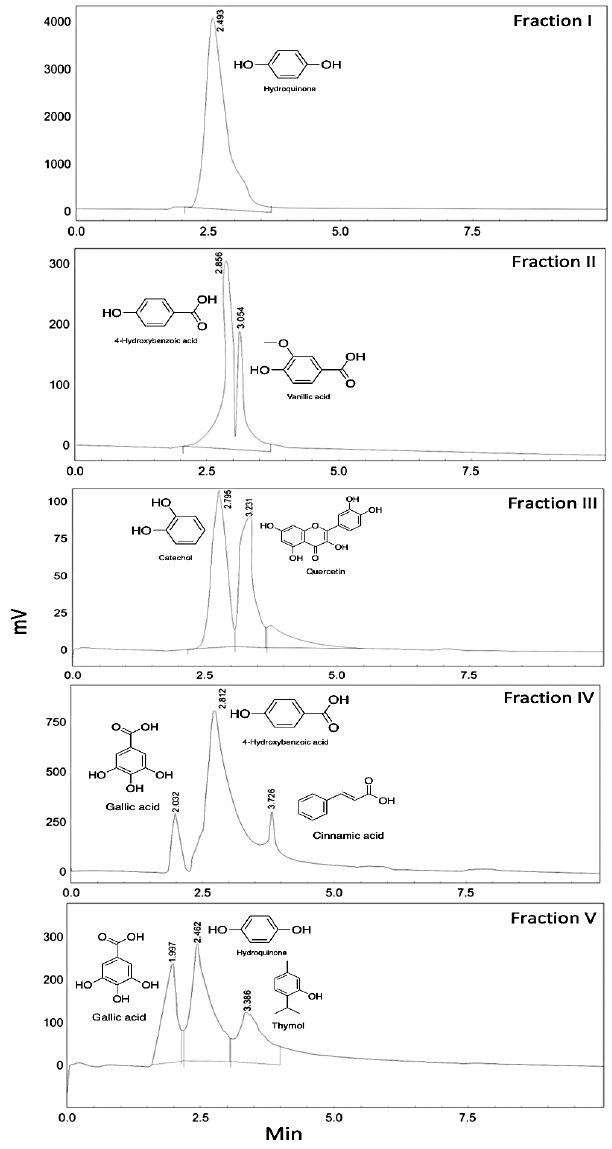
Figure 1. HPLC chromatogram of Fraction I-IV. Table 1. Phenolic compounds in different fractions and their retention time.